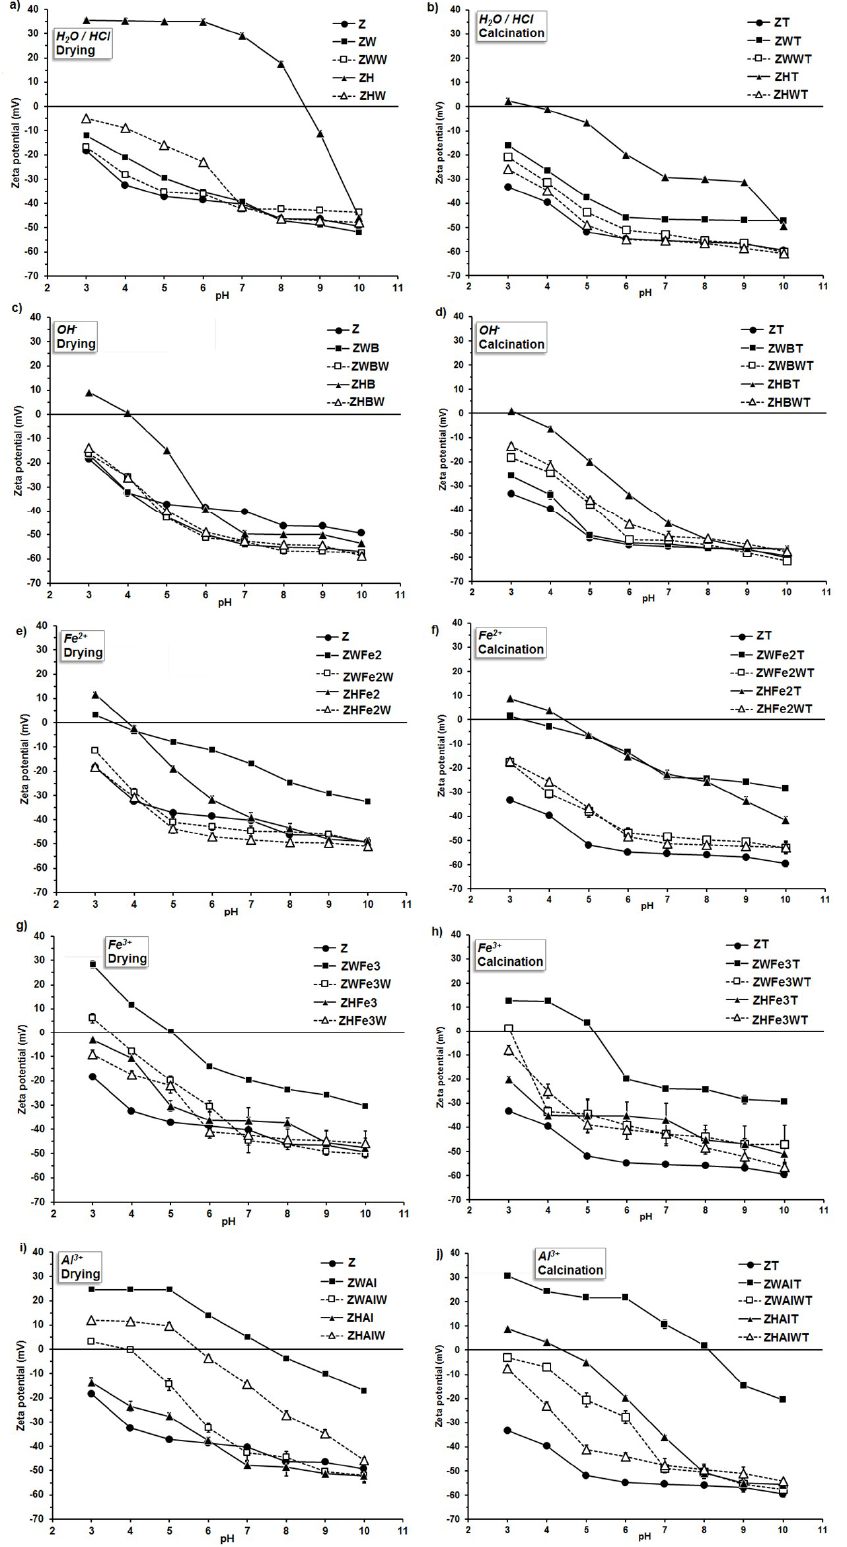
Figure 3. Zeta potential vs. pH dependence for the zeolie mofified by ( a ) the pretreatment with H 2 O or HCl; ( b ) the pretreatment with H 2 O or HCl and calcination; ( c ) the alkalization; ( d ) the alkalization and calcination; ( e ) the Fe 2 + action; ( f ) the Fe 2 + action and calcination; ( g ) the Fe 3 + action; ( h ) the Fe 3 + action and calcination; ( i ) the the Al 3 + action; ( j ) the Al 3 + action and calcination. The abbreviations of the sample names are in accordance to Figure 1.